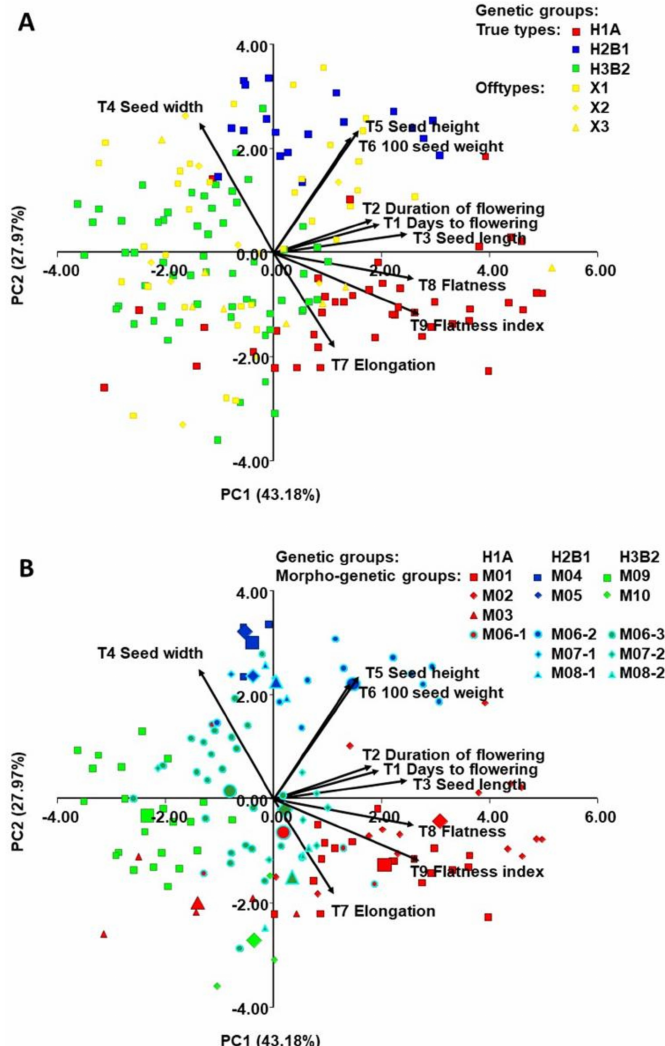
Figure 4. Principal component analysis (PCA) of Croatian common bean accessions based on nine morphological traits: ( A ) Plot showing classification of accessions into three true type genetic groups (H1A, H2B1, H3B2) and three off-type groups and ( B ) the same plot showing classification of true- type accessions into 14 morphogenetic groups (see Table 1). In B, each accession is indicated by a small sign, while the morphogenetic group barycenters (the average of morphogenetic groups) are represented by larger ones. The signs with light blue border indicate the morphotypes (landraces) that had been found in more than one genetic group and reclassified as different morphogenetic groups (M06 to M06-1, M06-2 and M06-3